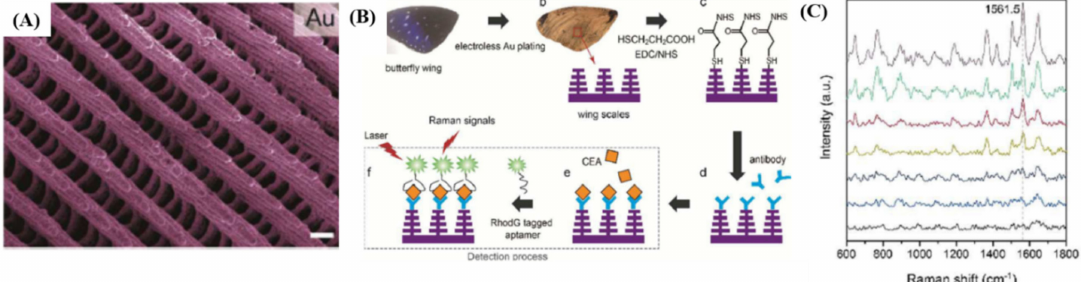
Figure 2. ( A ) Surface textures of the origin of butterfly wings covered with an Au layer of 40–70 nm thickness; ( B ) Schematic illustration representing the functionalization steps involved in the fabrication of butterfly wings for carcinoembryonic antigen (CEA) detection; ( C ) Surface enhanced Raman spectroscopy (SERS)-based CEA detection for five different clinical samples. (Reproduced with permission from Reference [36] published by the Royal Society of